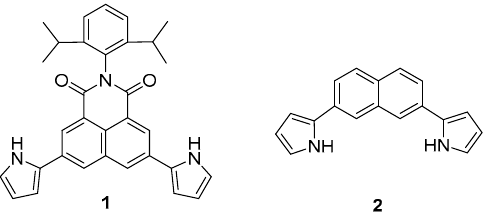
Figure 1. Molecular structures of receptors 1 and 2 .